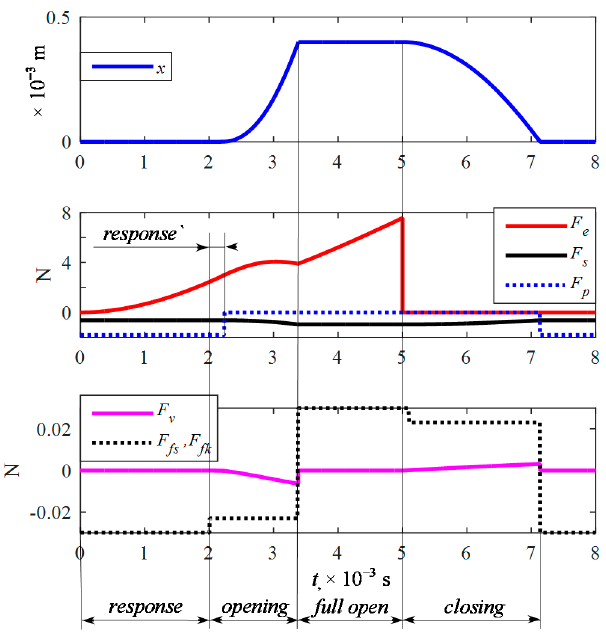
Figure 7. Variations of plunger displacement and acting forces were obtained by calculation at x max = 0.4 × 10 − 3 m.